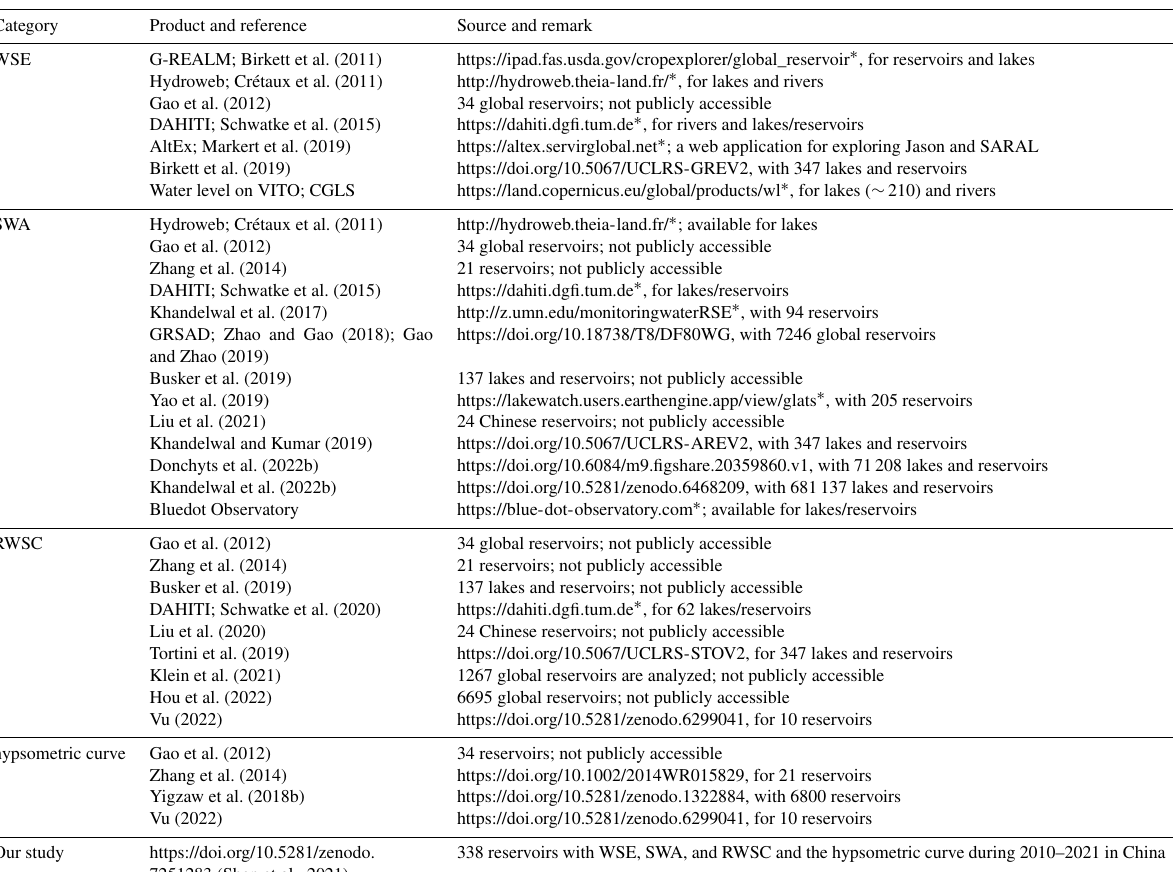
Table 1. Summary of recent studies and databases producing the remotely sensed data on WSE, SWA, and RWSC and the hypsometric curve of